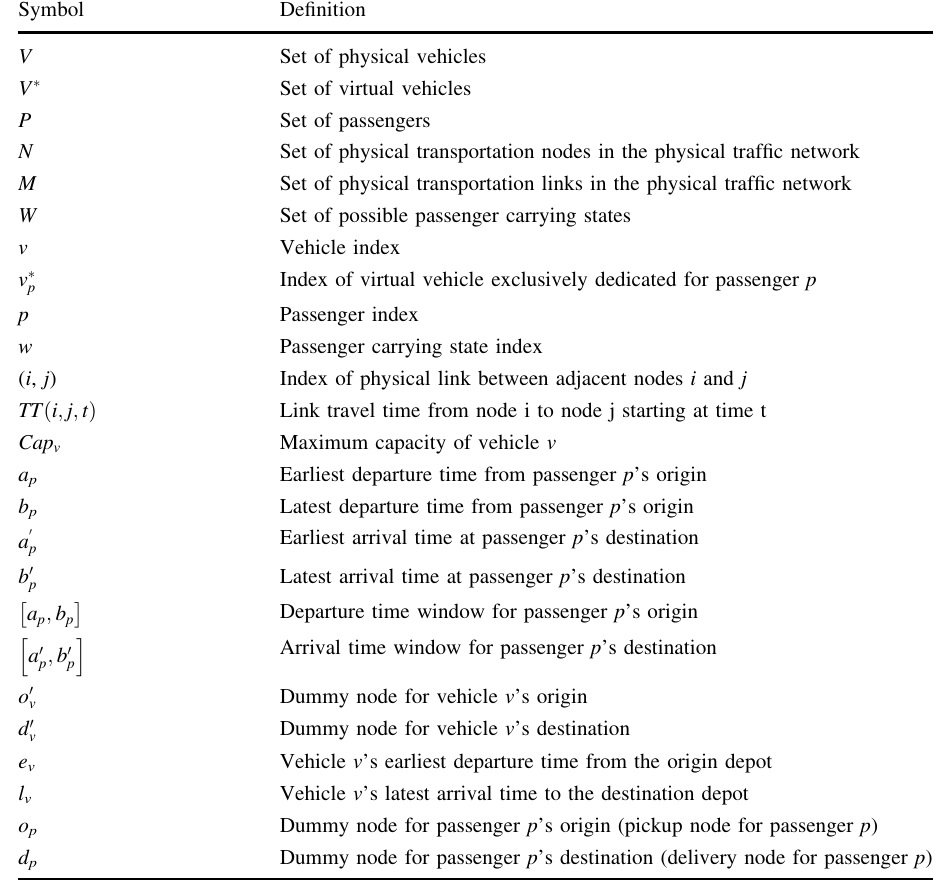
Table 3 Indexes and variables used to describe the VRPPDTW problem